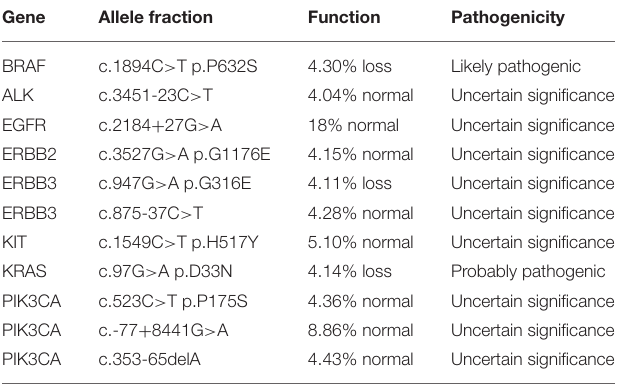
TABLE 1 | Tumor genetic